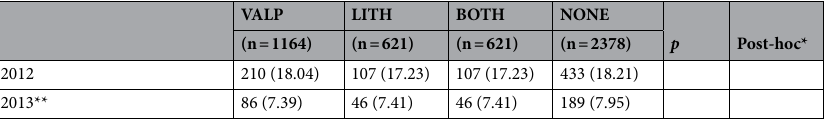
Table 1. Baseline characteristics of the valproate only users, lithium only users, both valproate and lithium users, and nonusers. Values are presented as mean ± standard deviation, number only, or number (%). py, person-years; SSRI, selective serotonin receptor inhibitor; SNRI, serotonin norepinephrine receptor inhibitor; TCA, ticyclic antidepressants; H2RA, histamine 2 receptor antagonist; ERT, estrogen replacement therapy. *a: Lithium only users, b: Valproic acid only user, c: both users, d: both non-users. **Others included bicalutamide, buspirone, digoxinm, and tirpramide. ***Until August.